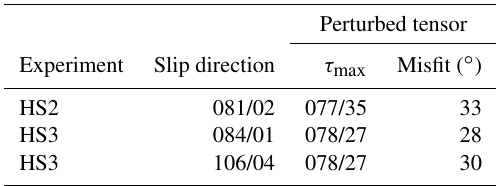
Table 6. Orientation of slip dislocation on the fractures estimated from the pre- and post-stimulation ATV logs and the maximum shear stresses resolved on the fractures from the perturbed stress tensor. All orientations are given as dip